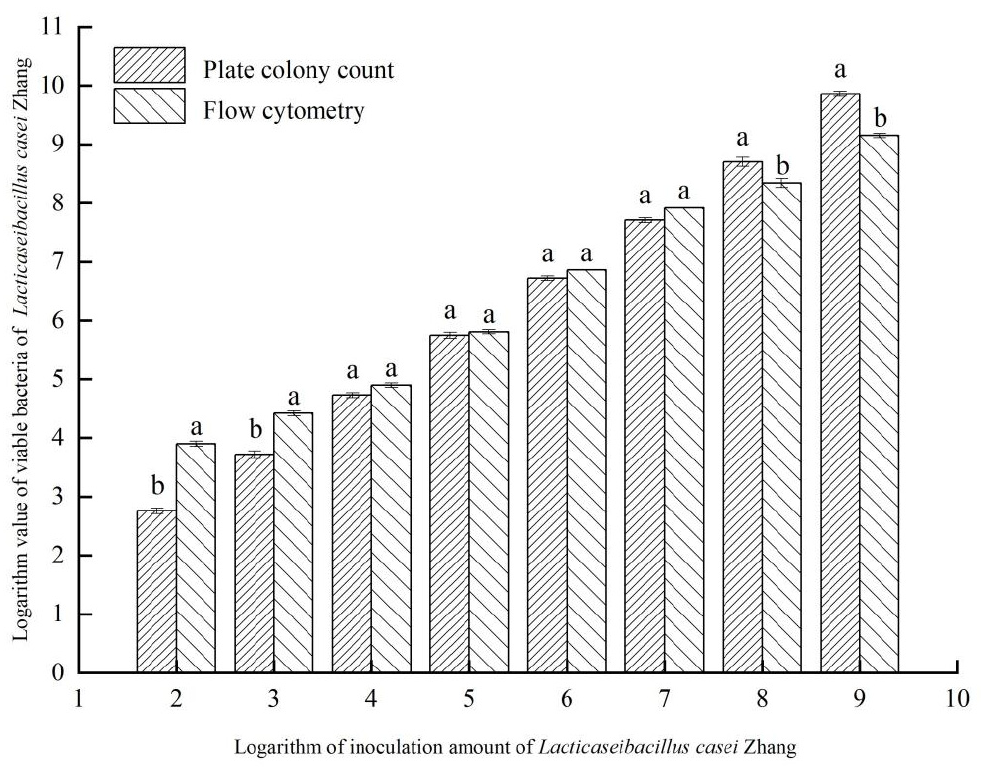
Figure 2. Comparison between flow cytometry and plate colony counting in enumerating Lacticaseibacillus ( Lb. ) casei Zhang. Different letters written above the bars indicate significant differences ( p < 0.05, T-student) between two detection methods at the same cell density. Bars represent means ± SD with no statistical differences between both methods and use letters a and b when there are statistical differences.